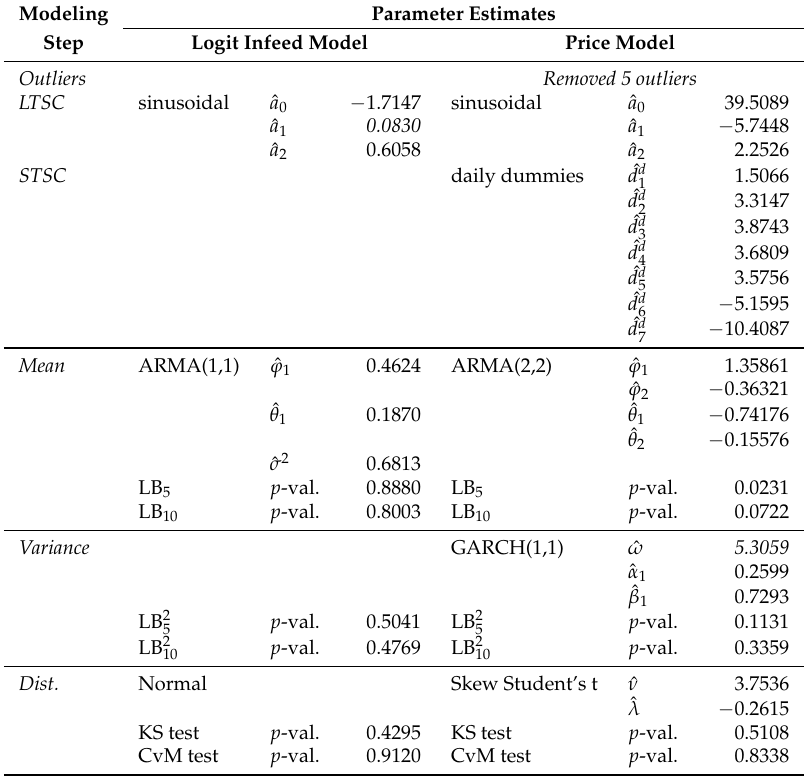
Table 3. Estimates for model parameters, goodness of fit measures, and distribution of standardized residuals for infeed and price data. Italic typeset denotes parameters that are not highly significant. ˆ d d refers to Monday. The LB test subscripts indicate the lag. For the variance model, the squared residuals are